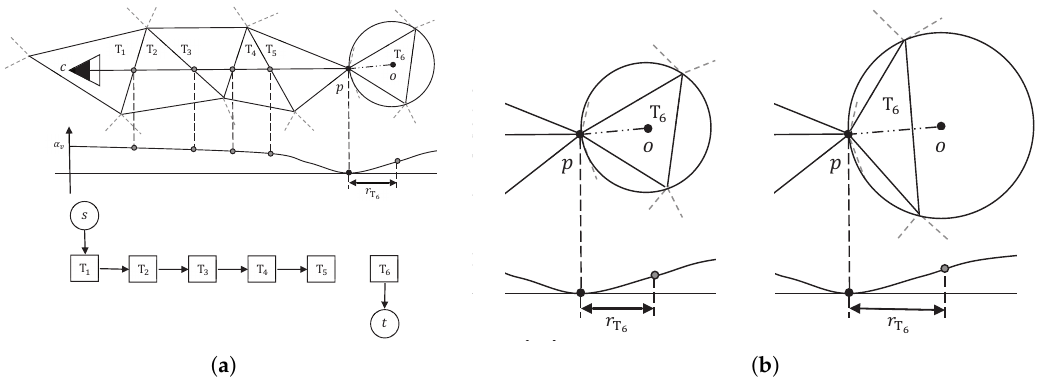
Figure 4. Our visibility model and end tetrahedra comparison in 2D. ( a ) In our visibility model, for a single line of sight v , how to assign weight (energy) to the tetrahedron containing camera center, the end tetrahedron and the facets intersected by ( c , p ) is shown. ( b ) From left to right: Typical end tetrahedron of noise points and that of true surface points on densely sampled